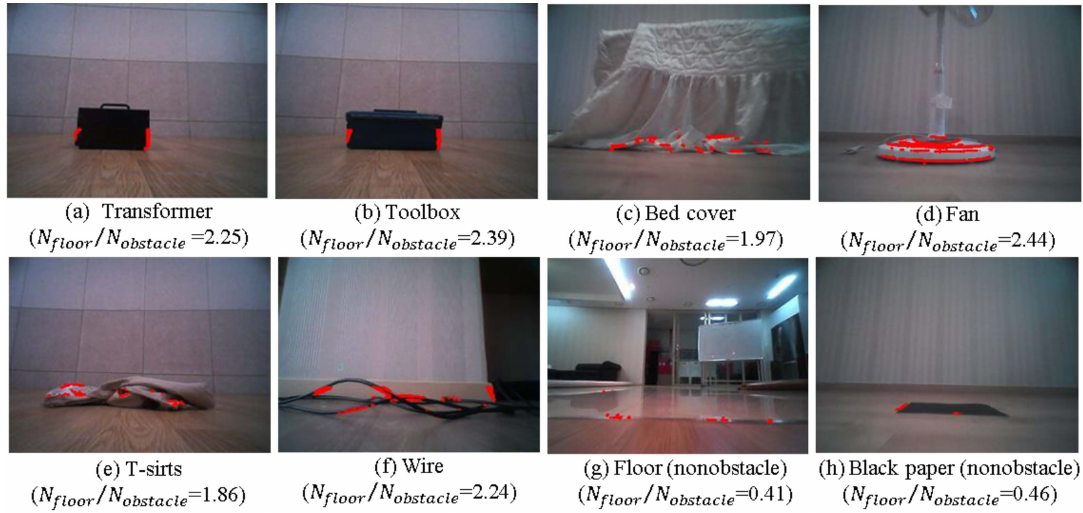
Figure 11. Examples of calculated ratio N floor / N obstacle for various